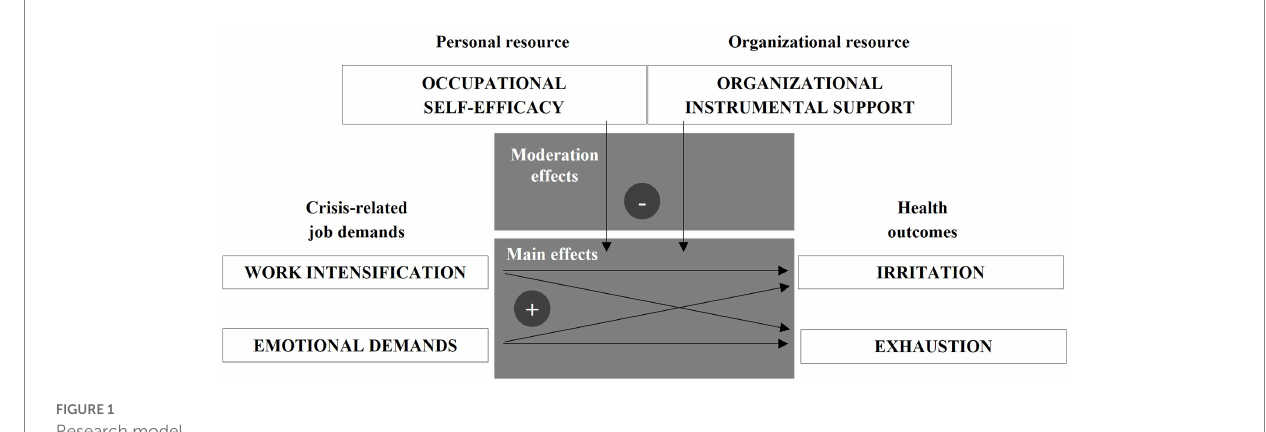
FIGURE 1 Research model.